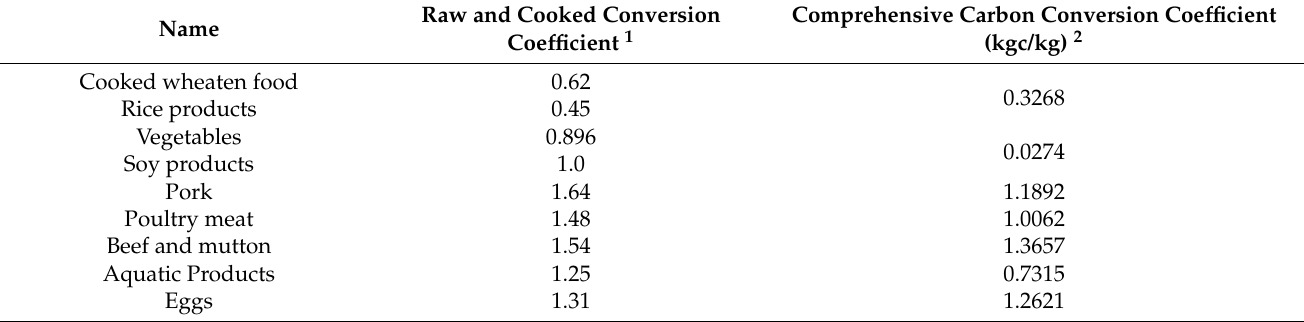
Table 3. Food raw and cooked conversion coefficient and comprehensive carbon conversion